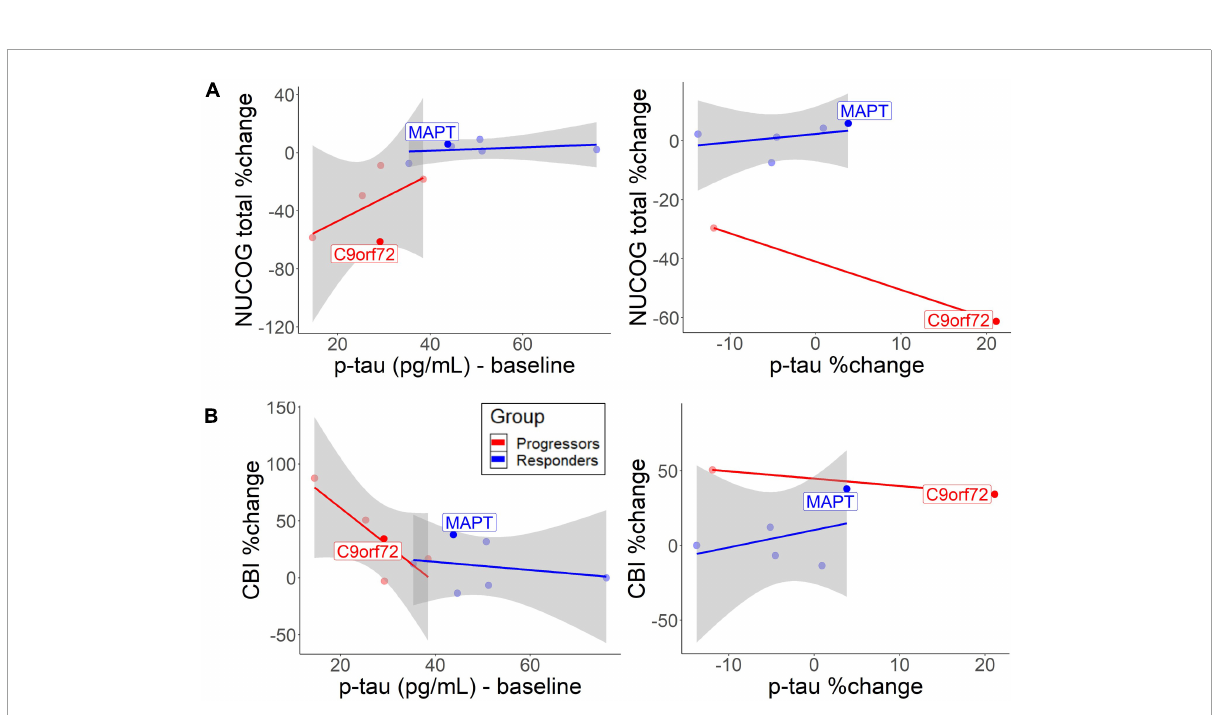
FIGURE4 Correlation between baseline/change CSF p-tau levels and (A) cognitive decrease and (B) behavioral change. The lines represent different groups. The left graphs represent p-tau baseline levels and the right graphs represent annual p-tau changes. Both patients with the identified mutation are